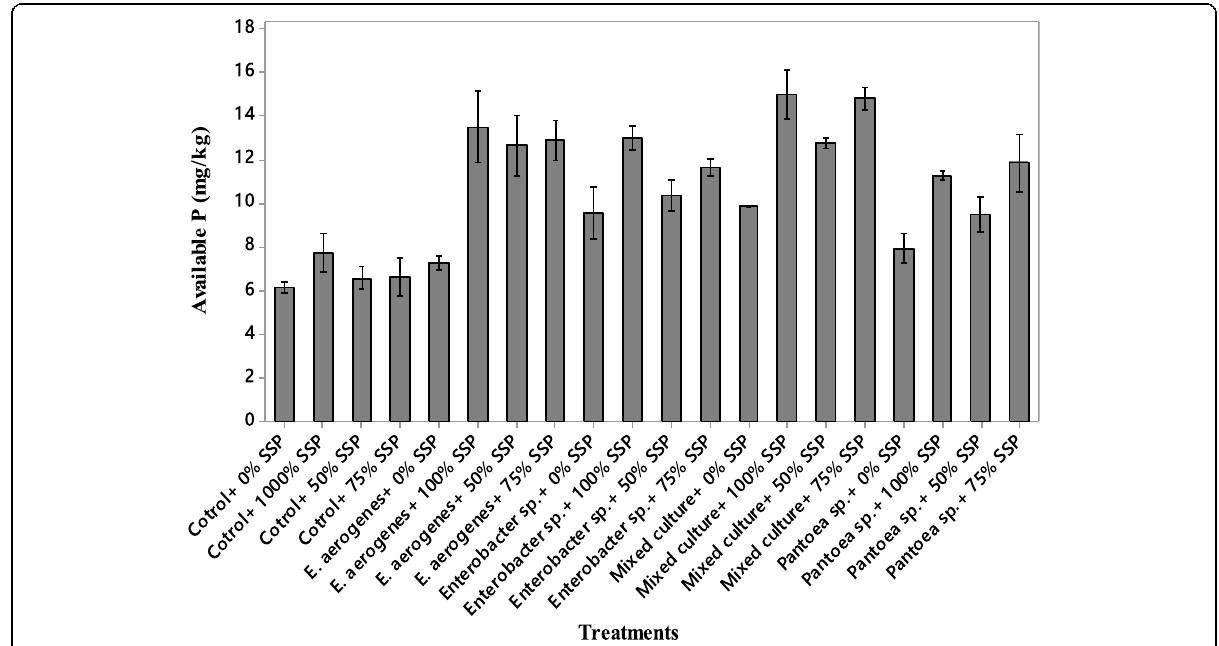
Fig. 3 Interaction effect between bacterial isolate and phosphorus fertilizer % on available phosphorus in the soil